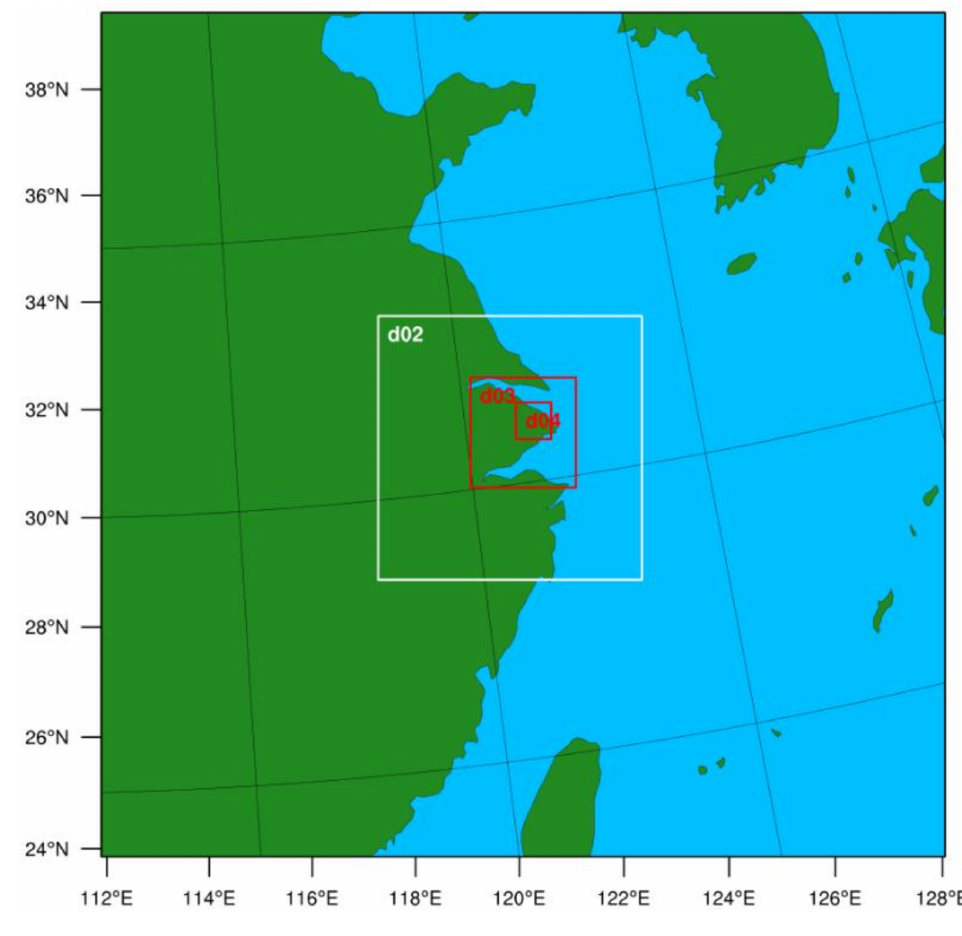
Figure 5. Research domains in the WPS. Table 2. Values of key parameters in the UCM